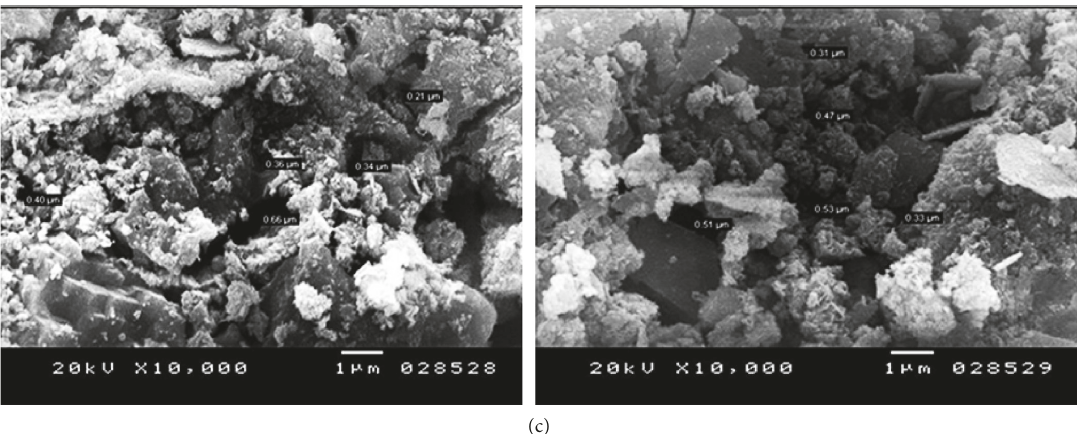
Figure 2: SEM of (a) raw oil shale, (b) thermally activated oil shale, and (c) chemically activated oil shale.